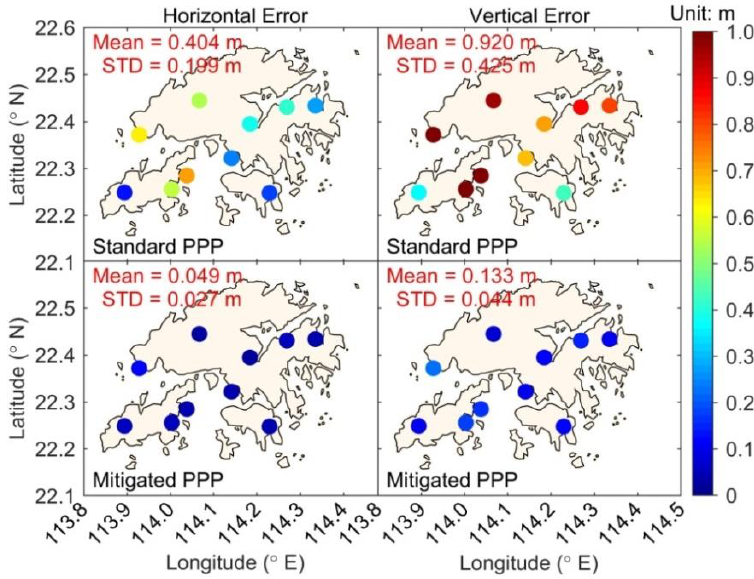
Figure 13. Positioning results of standard BDS PPP (upper panels) and mitigated BDS PPP (bottom panels) in the horizontal and vertical components on 20 October 2015 (DOY 293).